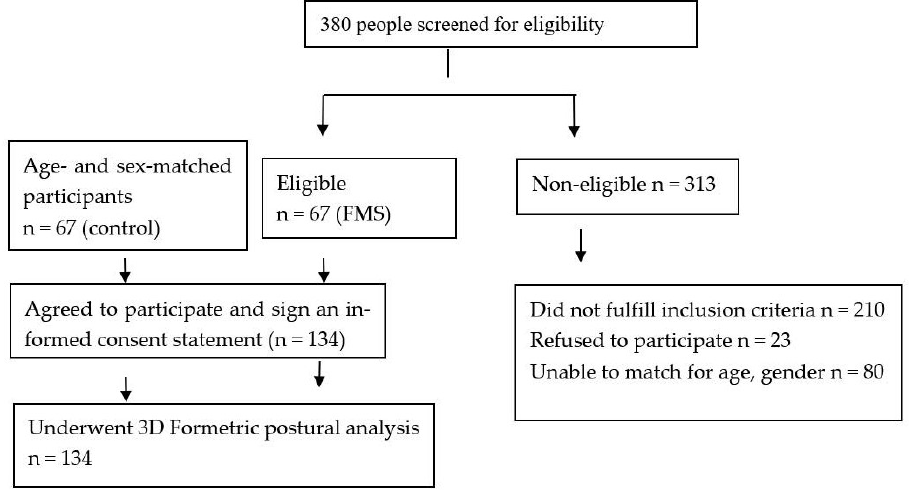
Figure 2. Participant flow chart.